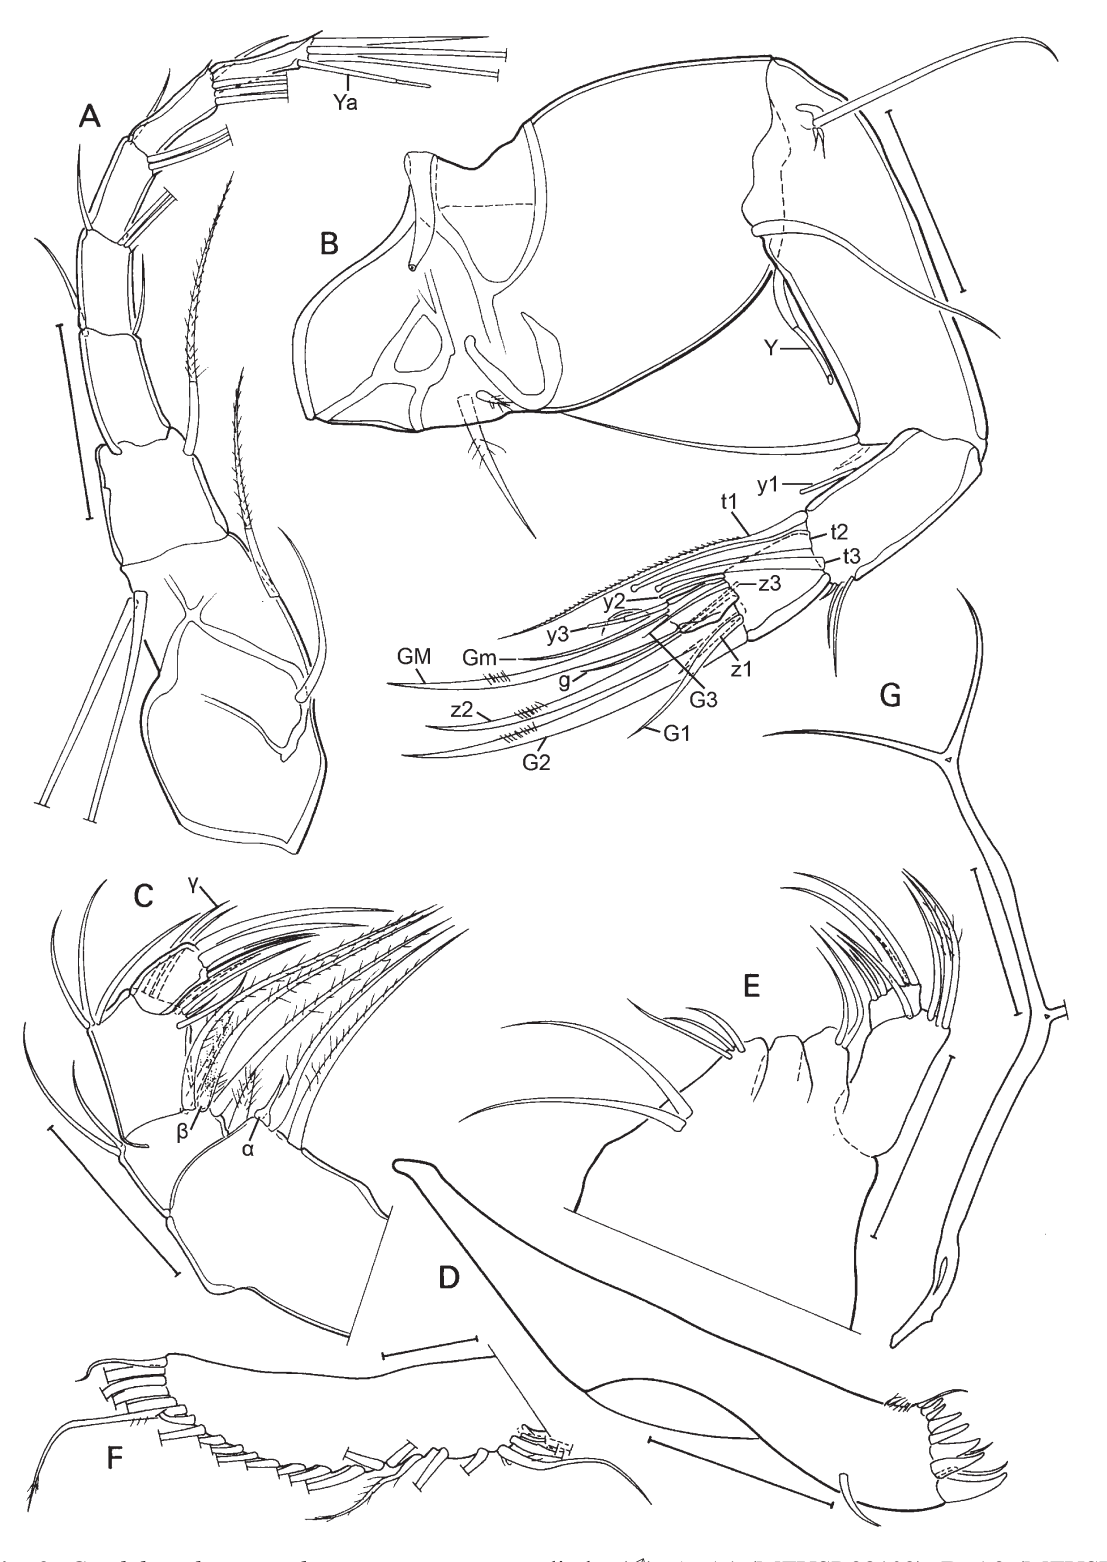
Fig. 3. Candobrasilopsis rochai gen. nov. sp. nov., limbs (♂). A . A1 (MZUSP.28102). B . A2 (MZUSP. 28114). C . Md palp (MZUSP.28114). D . Md, coxal plate (MZUSP.28114). E . Mx1 (Chaetotaxy incomplete) (MZUSP.28105). F . Mx1, respiratory plate (MZUSP.28114). G . Attachment of the caudal ramus (MZUSP.28104). Scale bars: A-G = 50